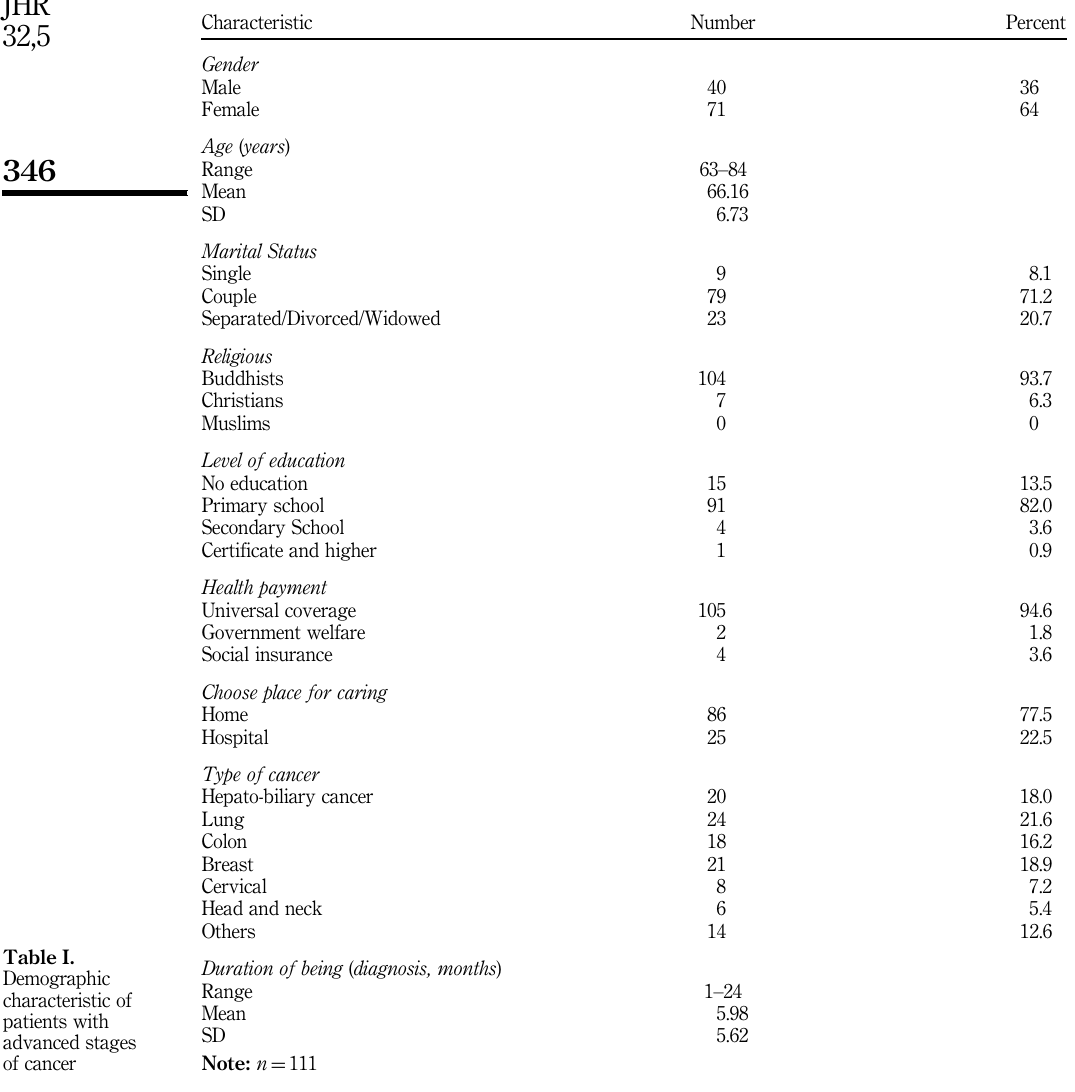
characteristic of patients with advanced stages of